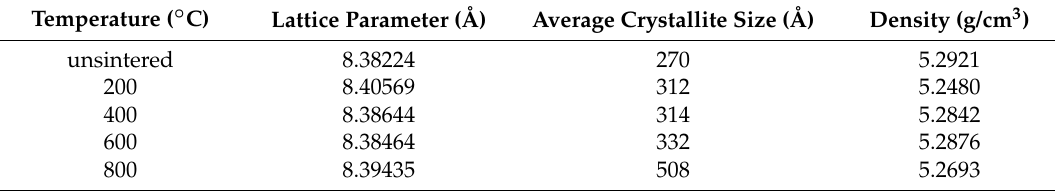
Table 2. XRD date of Co 0.9 Zn 0.1 Fe 2 O 4 sintered at different